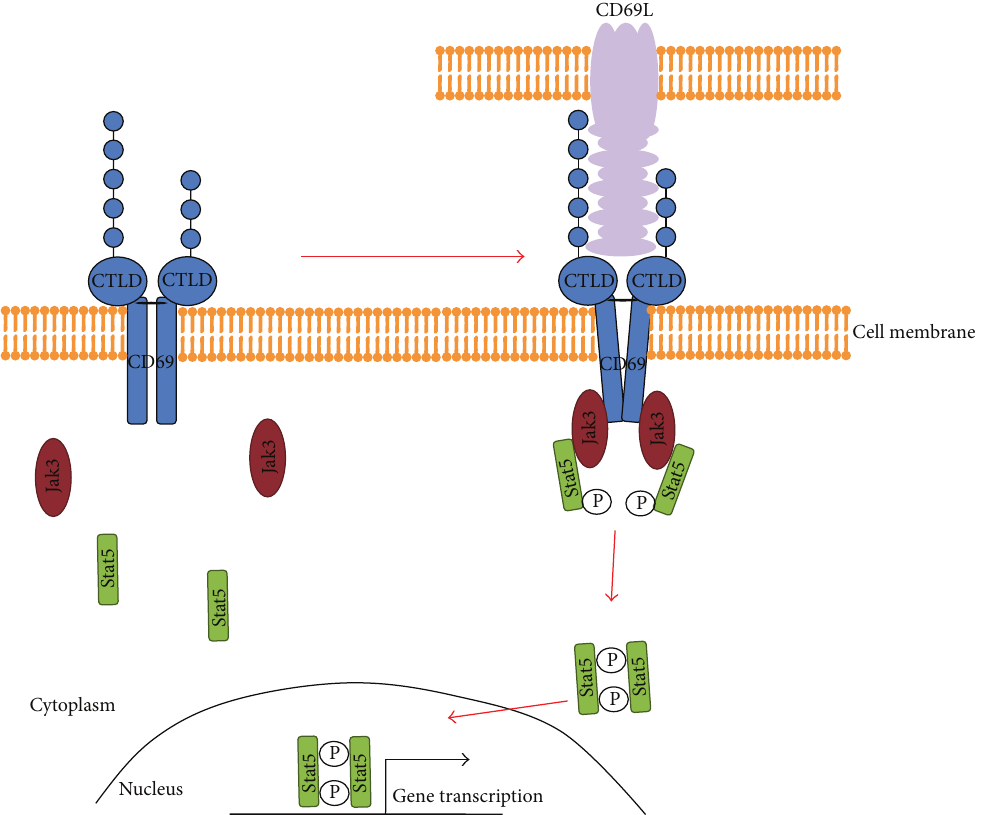
Figure 2: The proposed signalling pathway of CD69. After binding a putative ligand (CD69L) that is most probably a membrane bound protein, the cytoplasmatic tail of CD69 associates with Jak3 kinase. Jak3 recruits and phosphorylates the transcription factor Stat5. Phosphorylated Stat5 (Stat5-P) dimerizes in the active form and translocates to the nucleus where it can regulate the gene